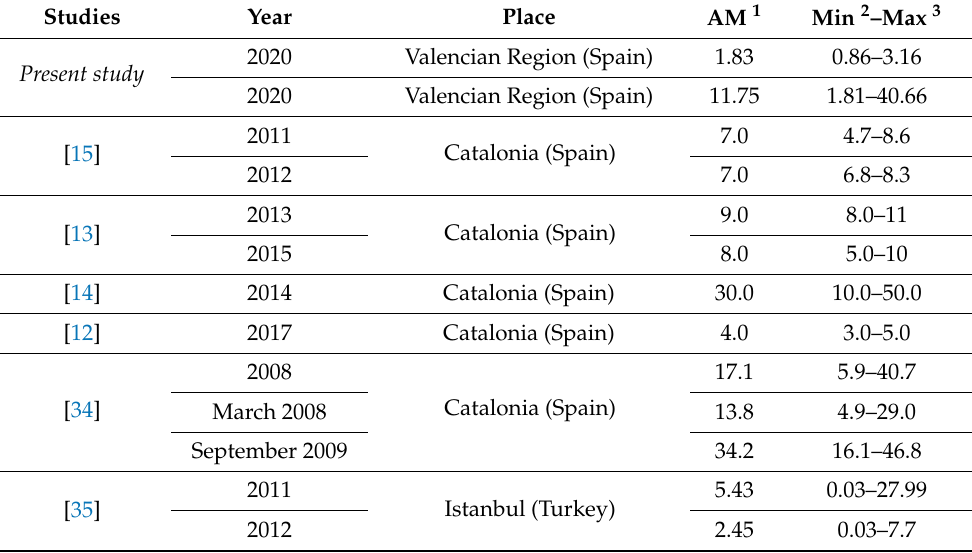
Table 2. PCDD/F air levels in the vicinity of cement plants in fg TEQ/m 3